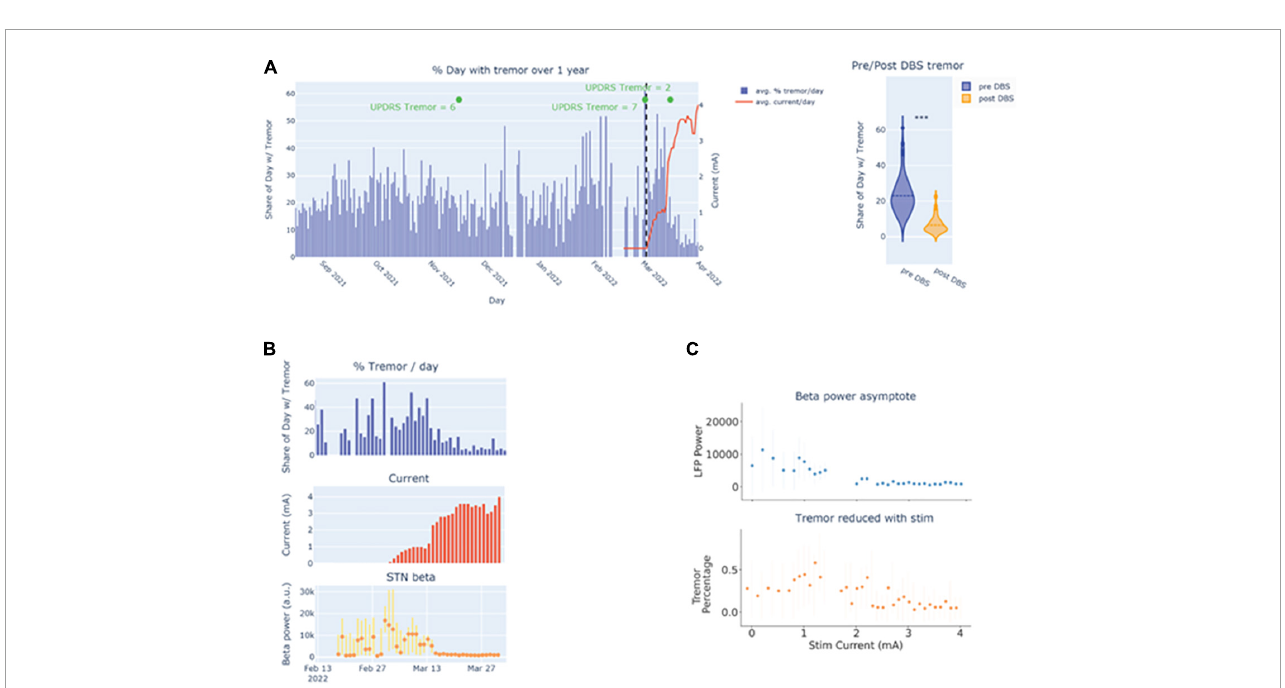
FIGURE6 (A) Visualization of tremor burden over time. (B) Viewing the temporal relationship between tremor burden with stimulation amplitude and beta power. (C) Visualizing the relationship between tremor and beta power with stimulation